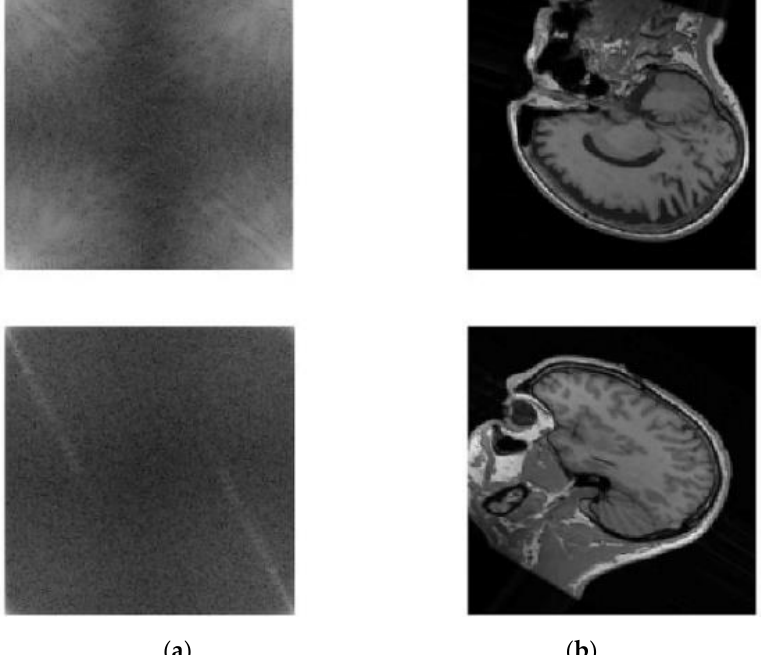
Figure 5. Data augmentation: ( a ) augmented k-space and ( b ) the corresponding reconstructed